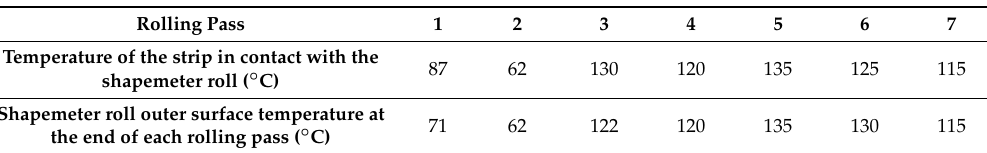
Table 3. Temperature of the strip in contact with the shapemeter roll and the roll outer-surface